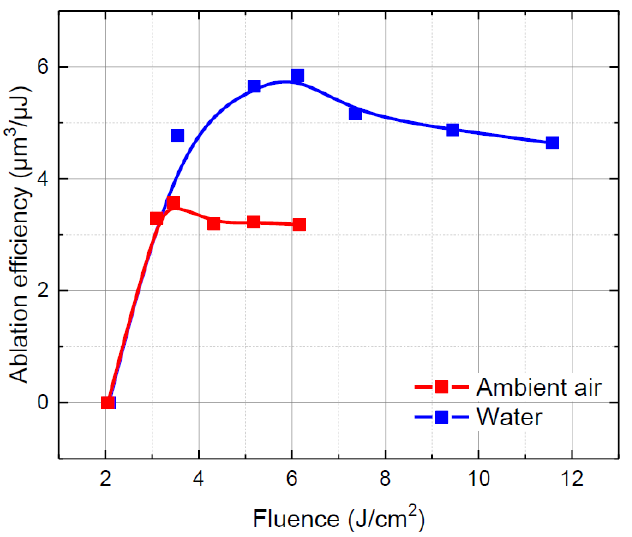
Figure 4. Ablation efficiency versus laser fluence in ambient air and water. Dots are connected to guide the eye.